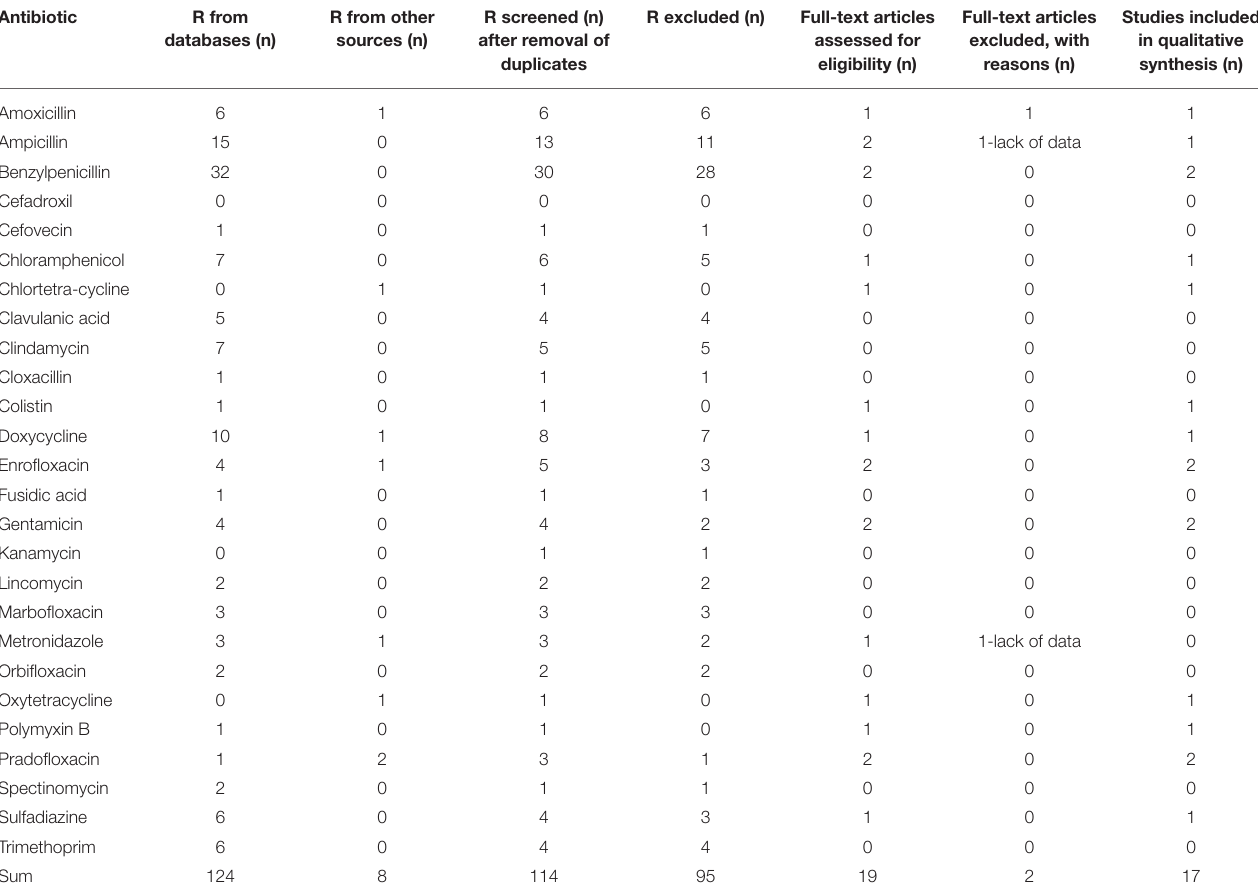
TABLE 2 | Literature search: Number (n) of records (R) identified for approved antibiotics in dogs. Antibiotic R from